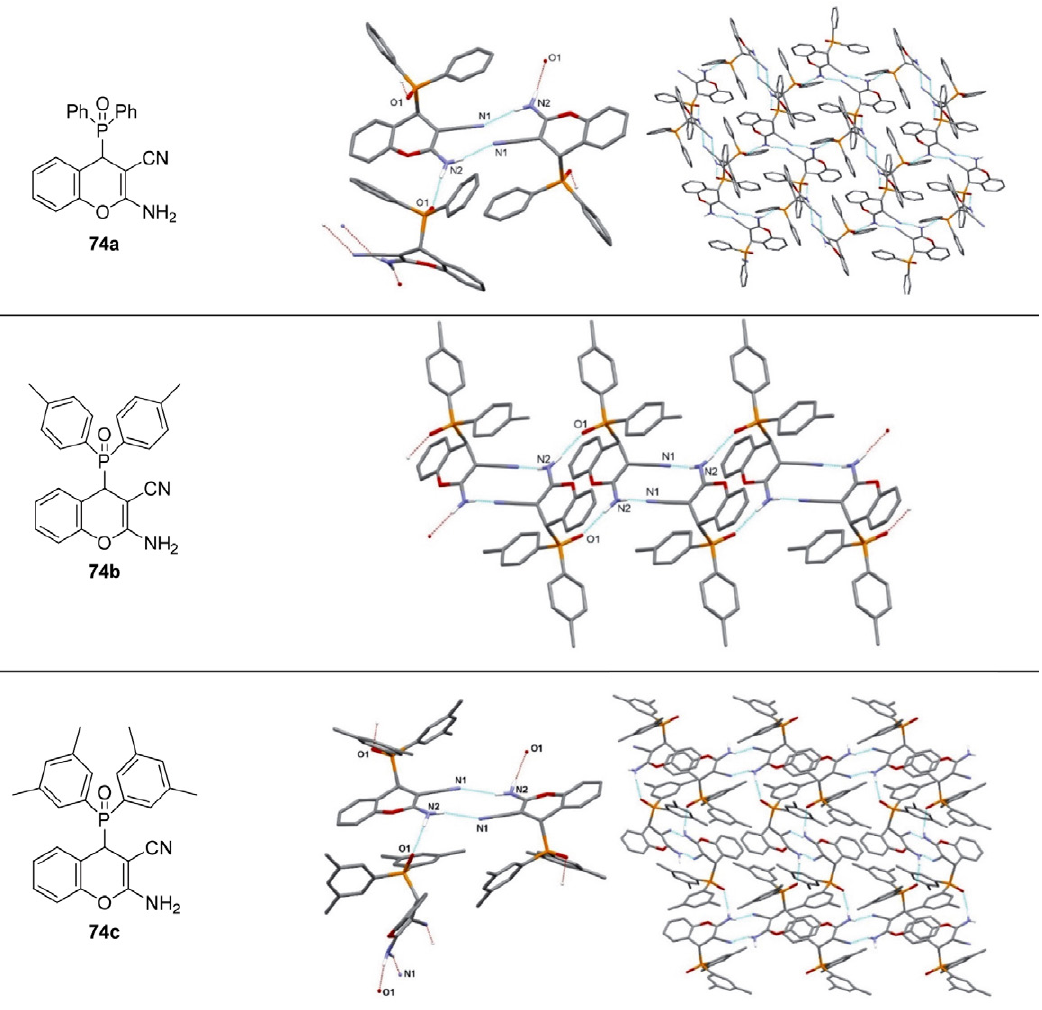
Figure 6. The crystal structure of 74a – c (2-amino-3-cyano-4 H -chromen-4-yl)phosphine